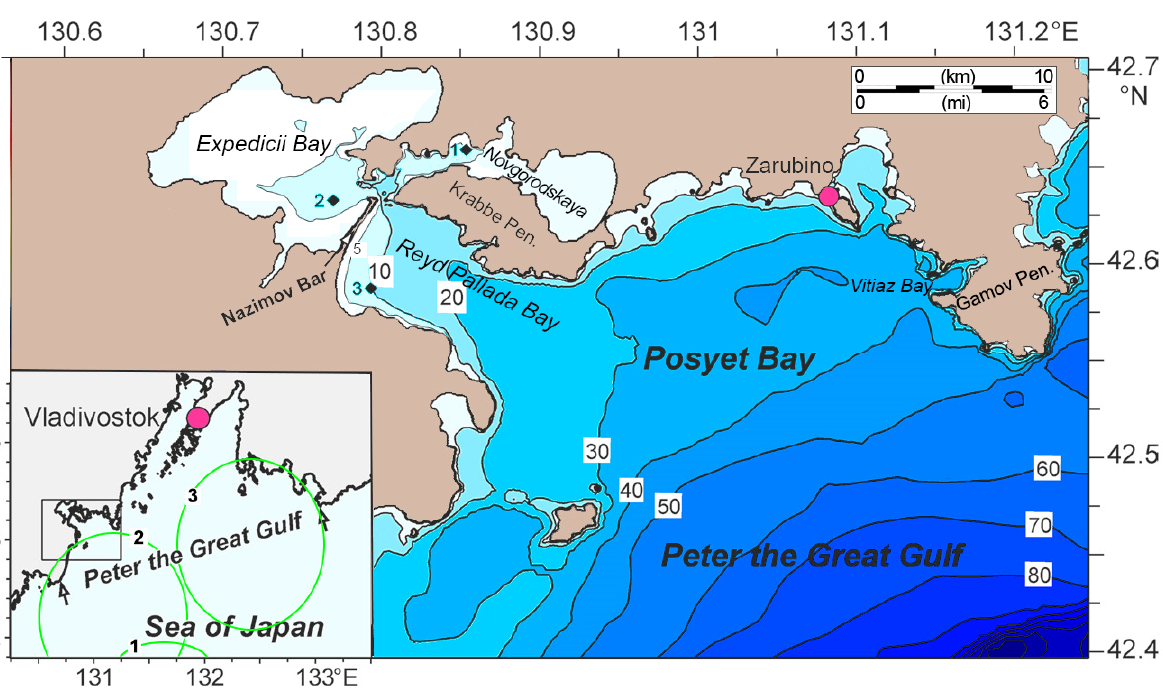
Figure 1. Map of experiments in the bays of the northwestern part of Posyet Bay in 2012 and 2014. Red dots—settlements, green circles—zones of wave generators, diamonds—points of oscillation measurements.